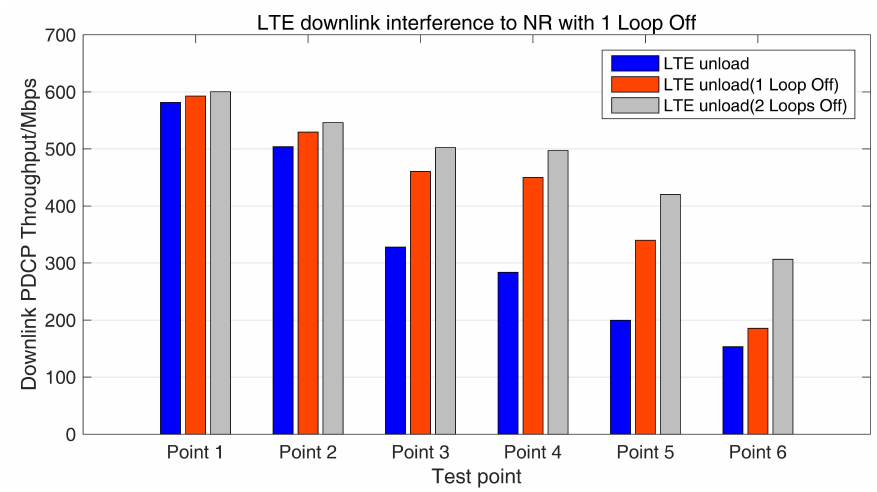
Figure 18. LTE to NR downlink interference test results—buffer setting (no load).